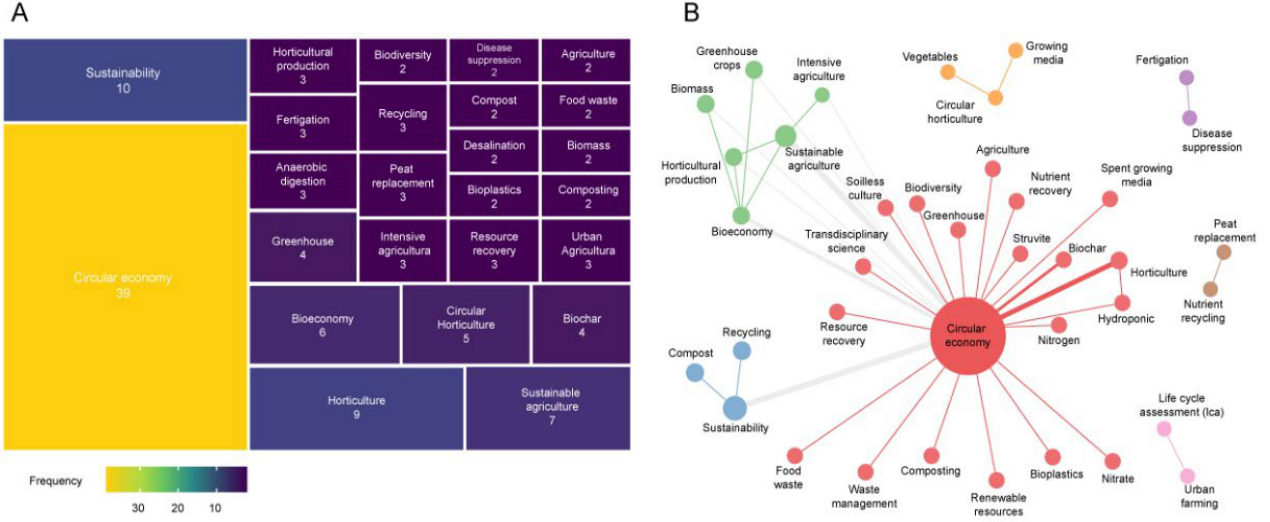
Figure 6. Use of keywords in research on circular horticulture. Frequency and percentage of the top 25 keywords ( A ) and co-occurrence map ( B )—own elaboration.